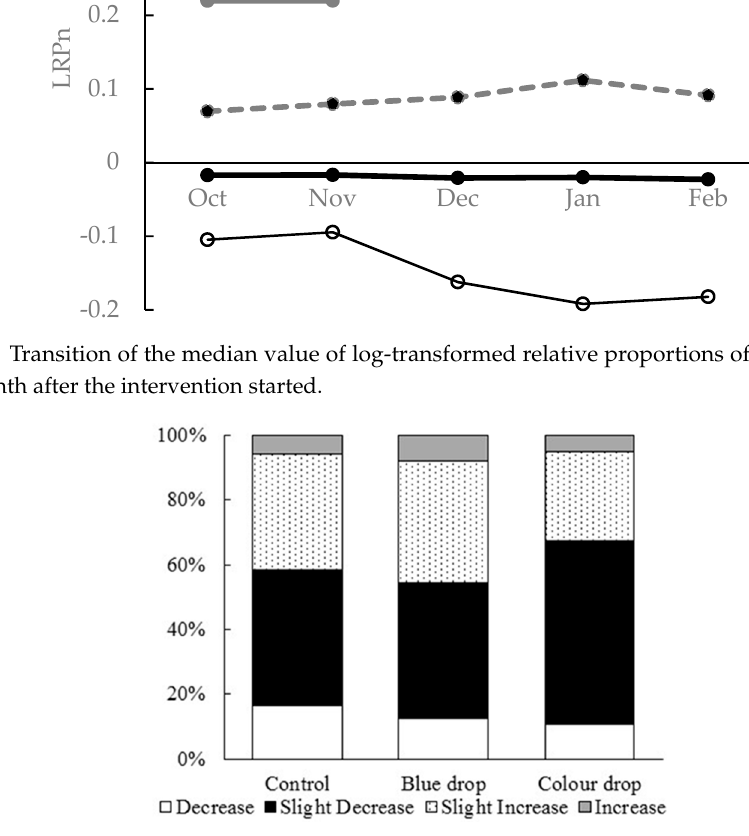
Figure 4. Proportion of households classified into four clusters.